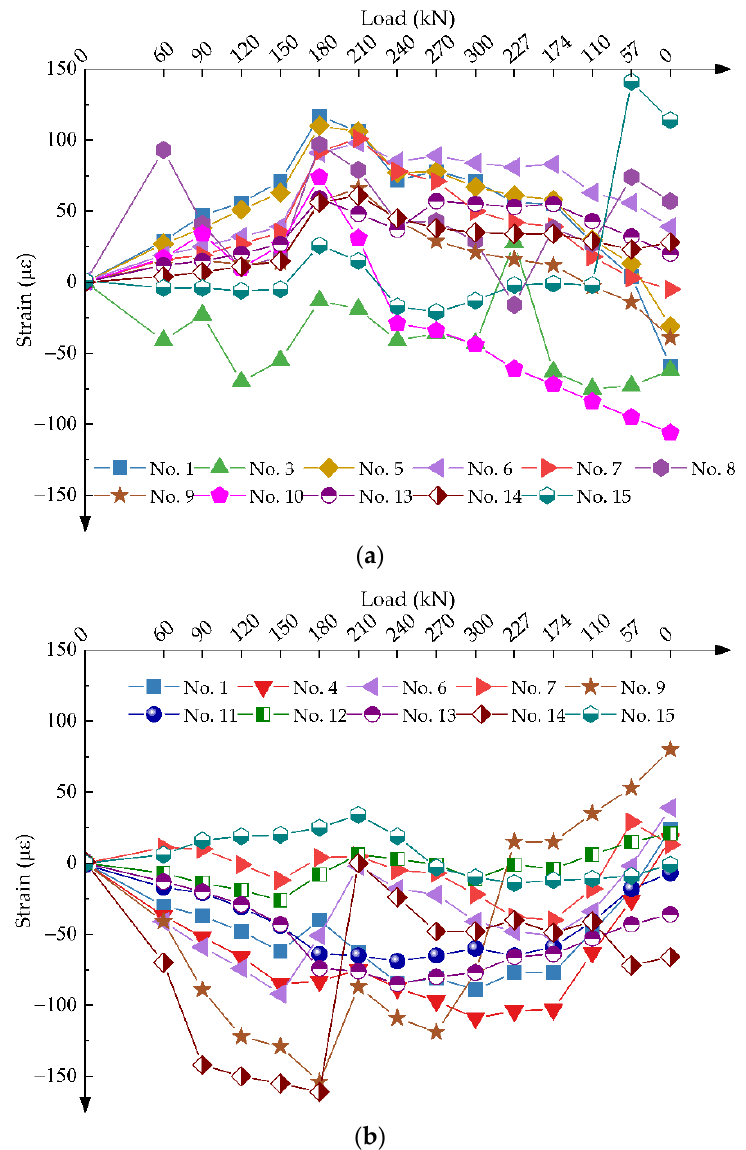
Figure 14. Strain test results of single pile No. 5: ( a ) strain–load curve of strain measuring point on the left side and ( b ) strain–load curve of strain measuring point on the right side.